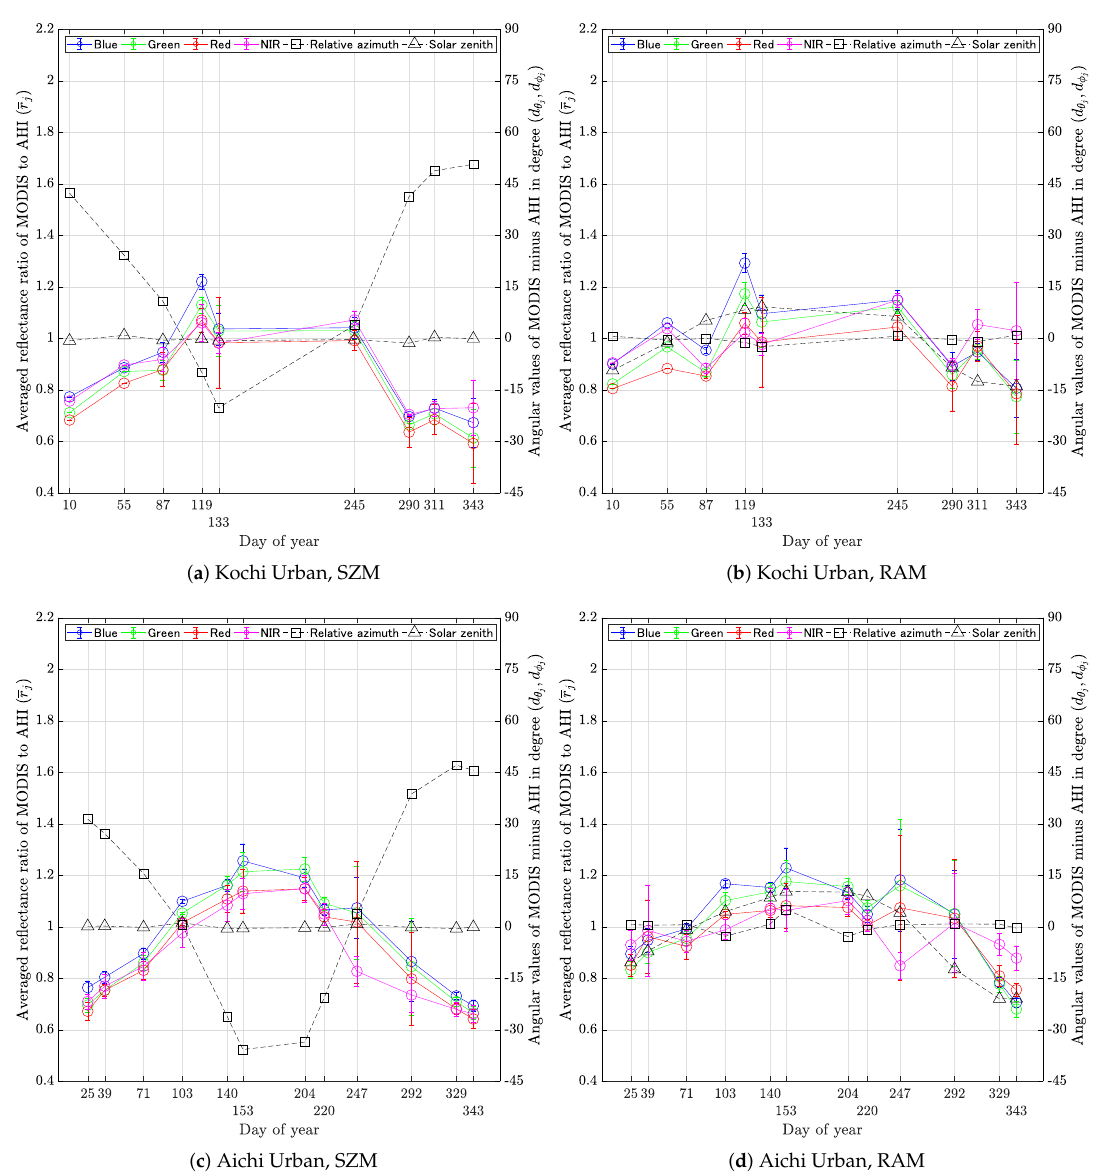
Figure 7. Area-averaged reflectance ratio (MODIS/AHI) for the urban ROIs. The upper two plots correspond to the Kochi Urban, SZM ( a ) and RAM ( b ). The lower two plots correspond to the Aichi Urban, SZM ( c ) and RAM ( d